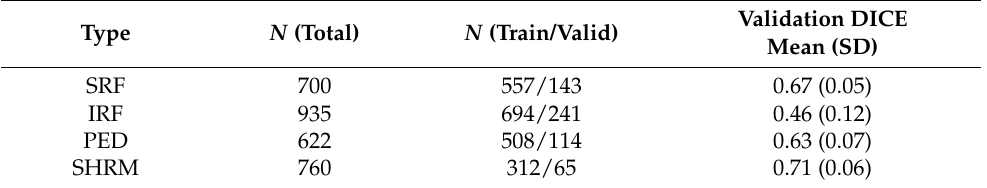
Table 1. Segmentation Performance—DICE Scores for the three fluids (IRF, SRF, PED), and SHRM.